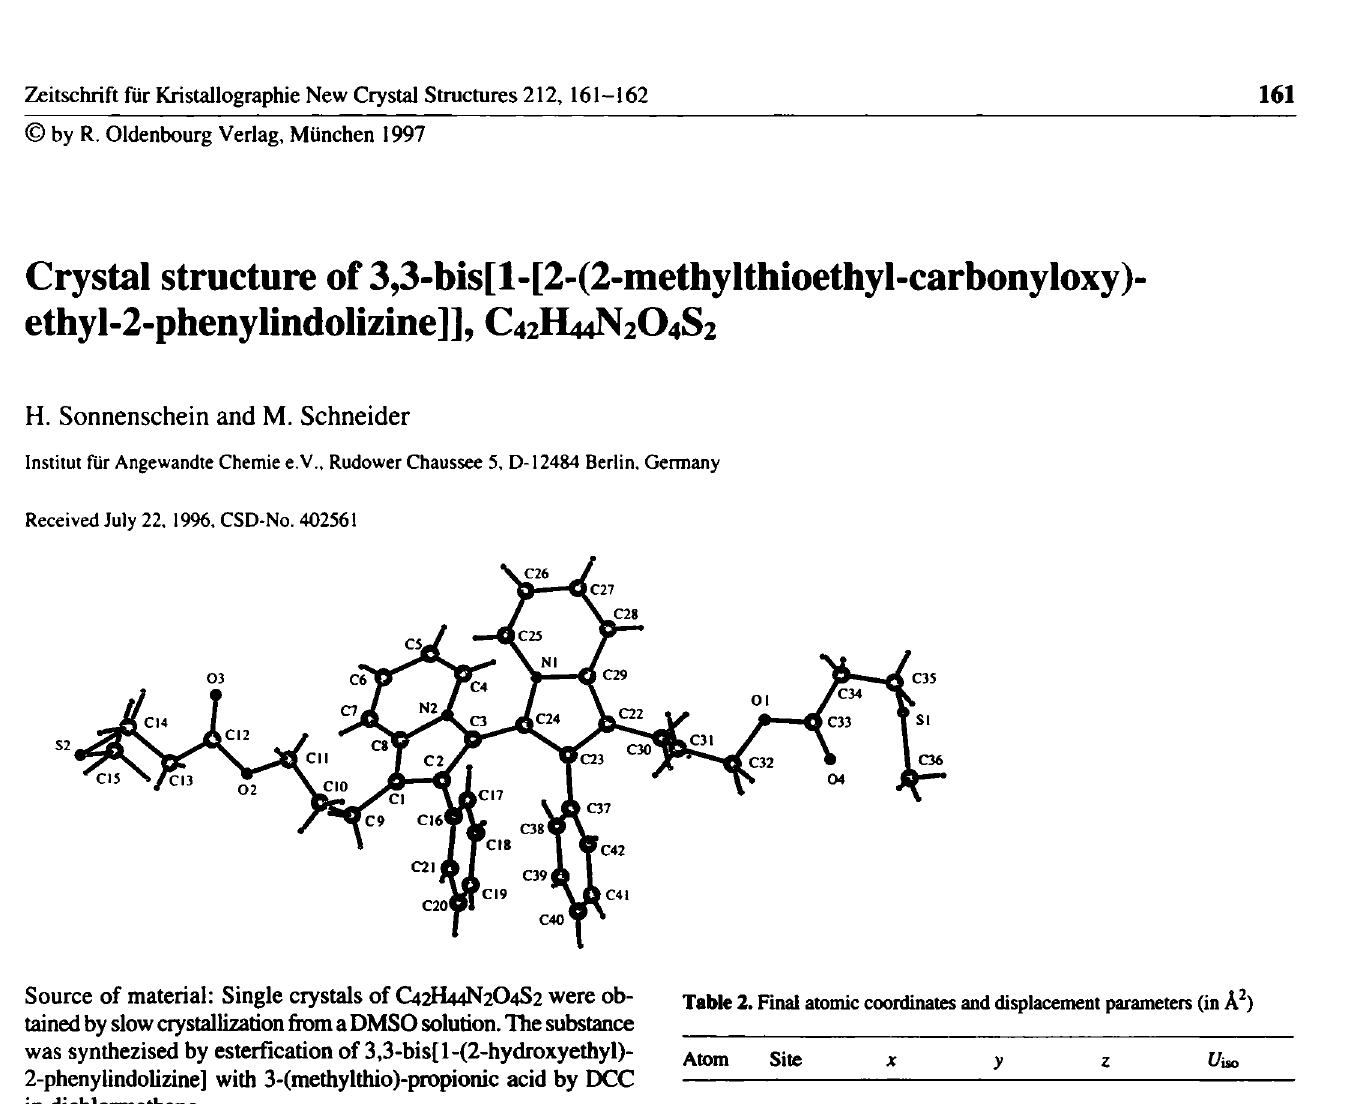
Table 2. Final atomic coordinates and displacement parameters (in Â 2